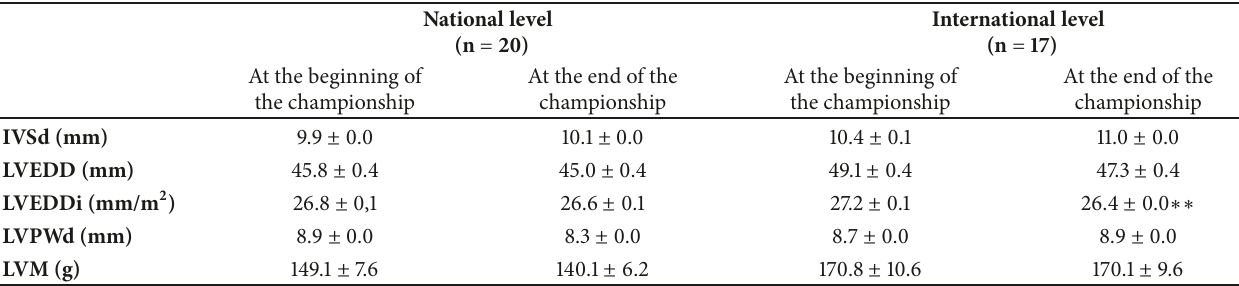
Table 1: Anthropometric parameters of a sample of soccer referees at the beginning and at the end of the Division 1 championship (Benin, 2016). N ational le v el I nternational le v el whole sa m ple ( n = 20) ( n = 17) n = 37 At the At the At the At the end of the At the end of the At the end of the beginning of the beginning of the beginning of the championship championship championship championship championship championship H ei g ht ( c m) 170.1 ± 1.4 - 176.4 ± 1.5 †† - 173.0 ± 1.1 - B ody m ass ( k g) 65.0 ± 1.8 63.7 ± 1.7 70.9 ± 1.8 † 70.6 ± 1.7 67.7 ± 1.3 66.9 ± 1.3 BMI ( k g/m 2 ) 22.5 ± 0.5 22.7 ± 0.5 22.7 ± 0.4 22.4 ± 0.3 ∗∗ WTA (H) 4.2 ± 0.8 - 8.0 ± 0.0 - 5.9 ± 2.0 - SIA ( year ) 1.8 ± 0.6 - 2.7 ± 0.4 - 2.2 ± 0.7 -